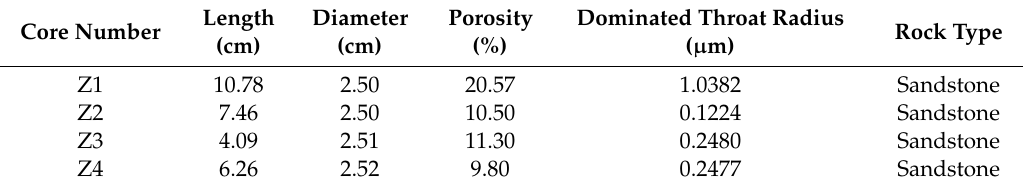
Table 1. The base data of experiment